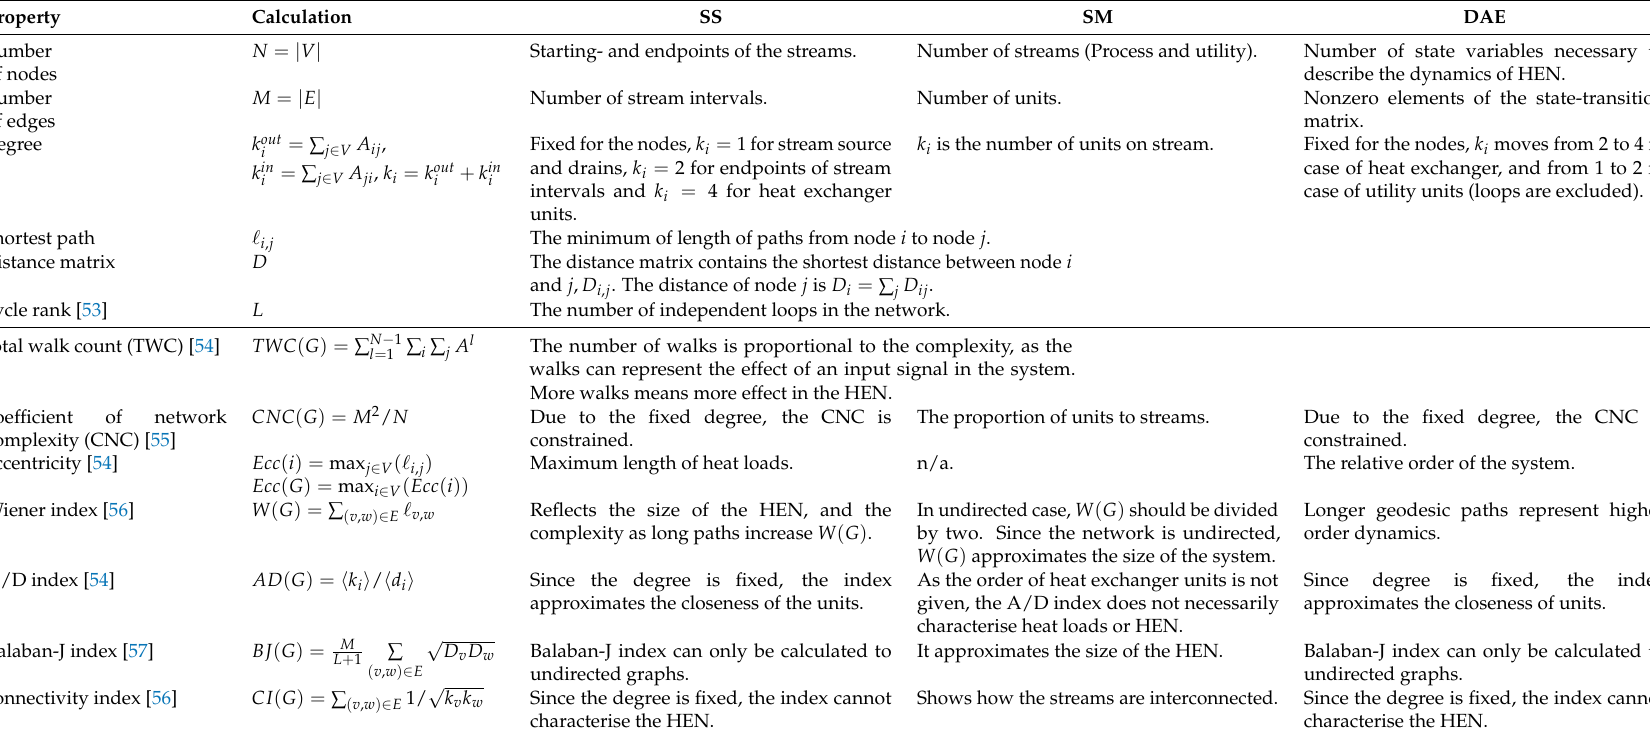
Table 2. Structural properties of the SS, SM and DAE-based network representations of HENs.The operator | X | yields the cardinality of set X , and the operator (cid:104) X (cid:105) yields the average of the values in X